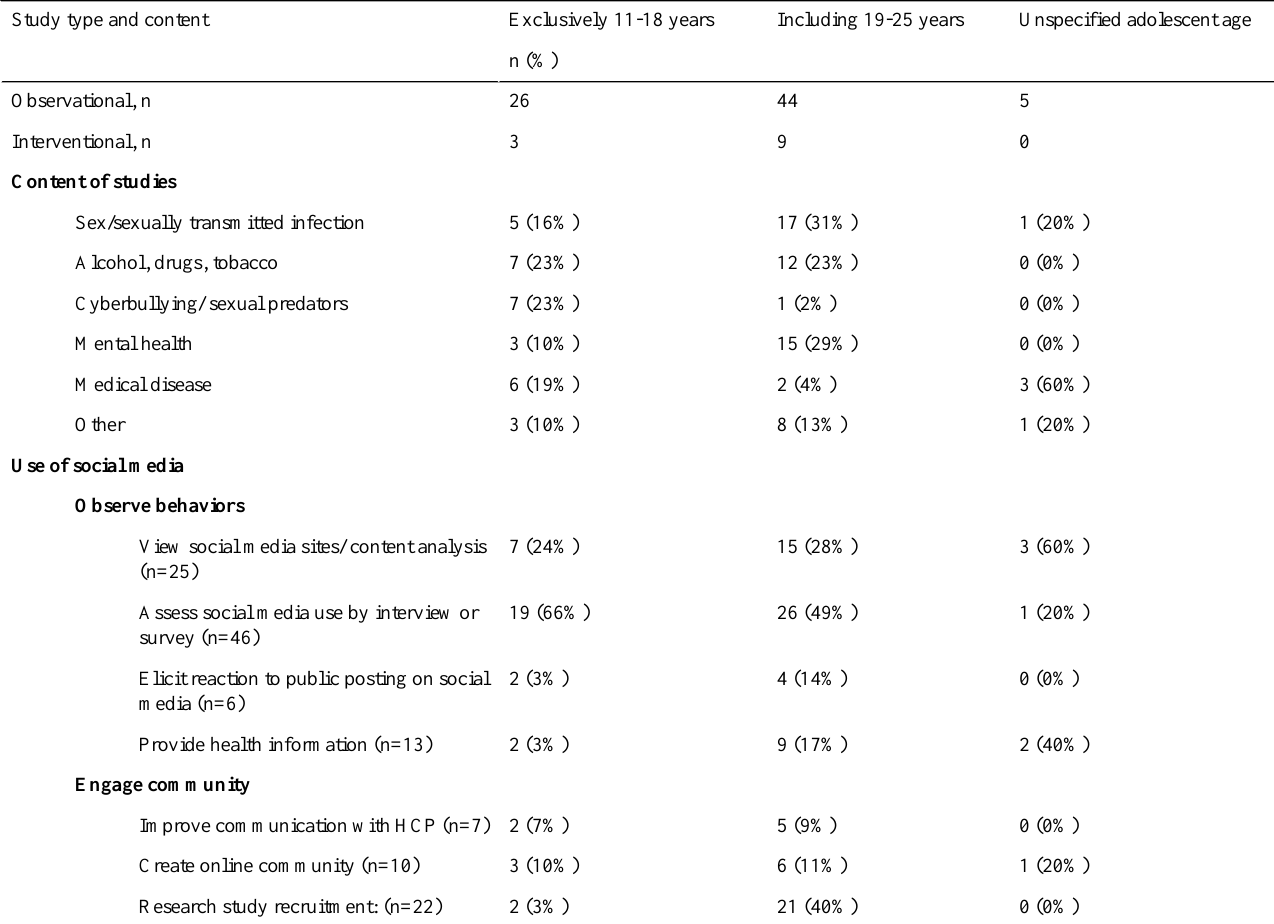
Table 6. Comparison of studies included in systematic review, by age of target population